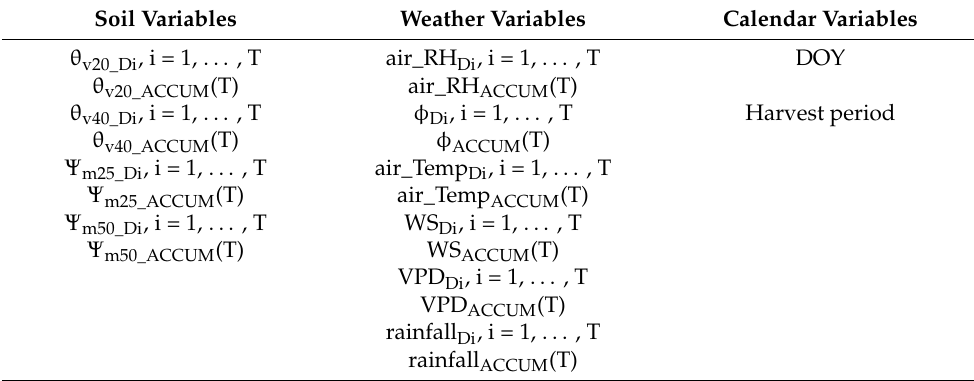
Table 2. List of models’ inputs considered in the